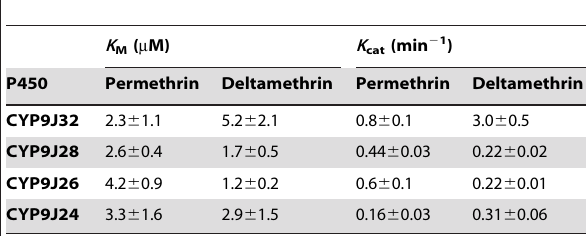
Table 4. Subsrate-saturation kinetic constants.